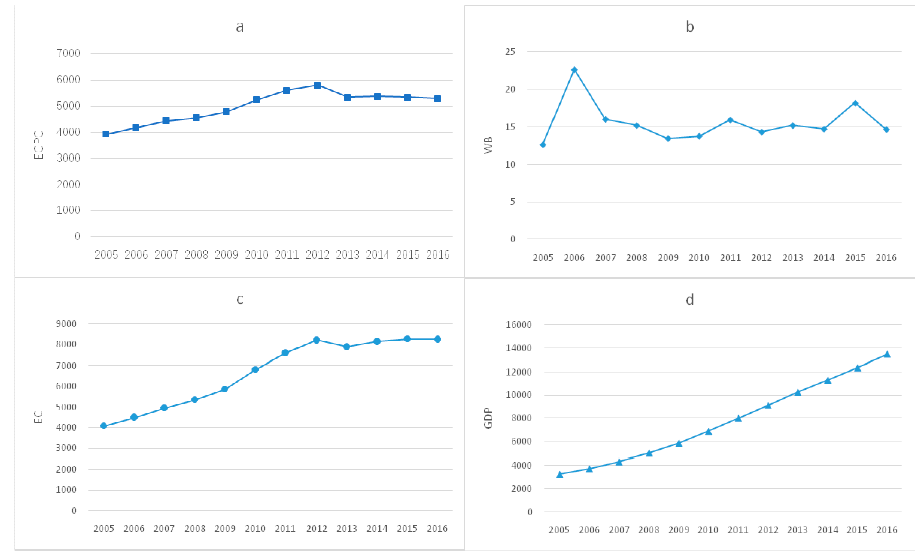
Figure 6. ( a ) Trends of ECPC in Tianjin; ( b ) trends of WB in Tianjin; ( c ) trends of EC (energy consumption) in Tianjin and ( d ) trends of GDP in Tianjin.